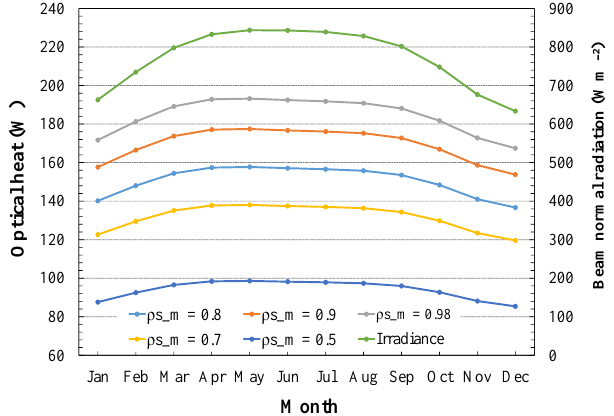
Figure 7. Optical heat variation as a function of the collector re- flectivity.